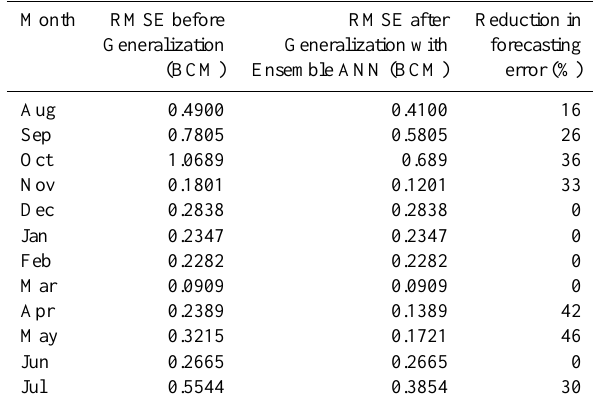
Table 3. RMSE associated with Ensemble ANN forecasting model before and after generalization